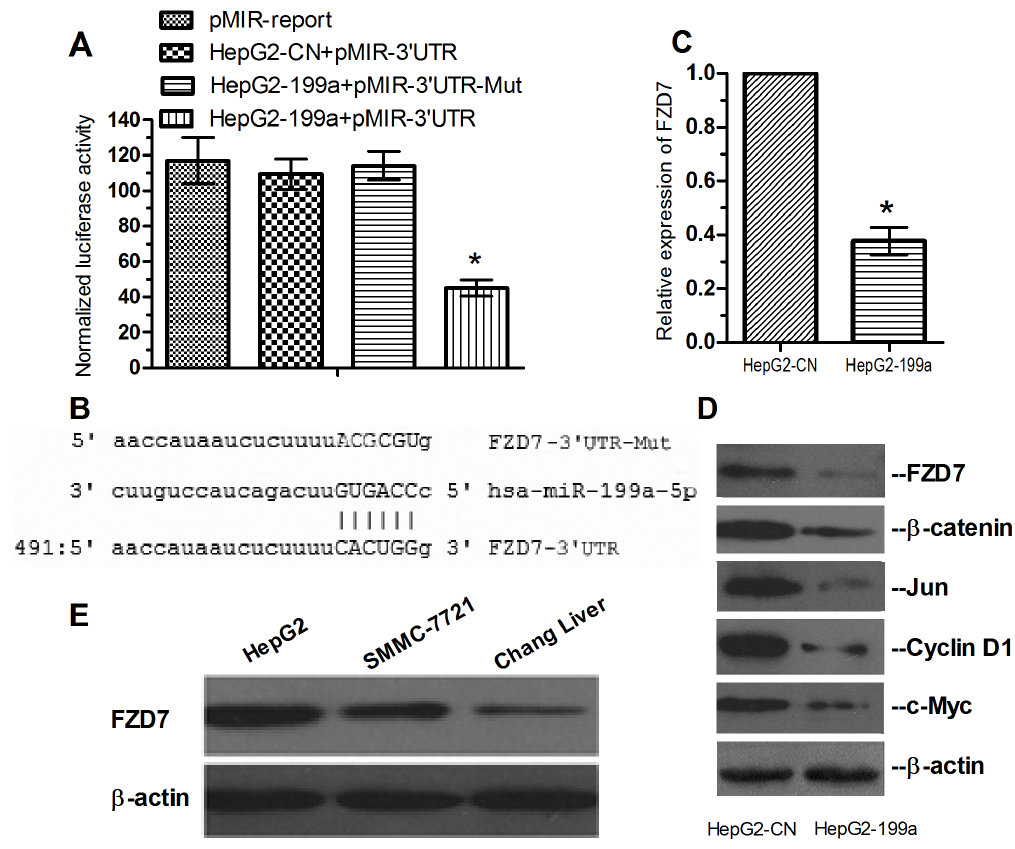
Figure 4. MiR-199a inhibits cell proliferation by directly targeting FZD7. (A) Dual luciferase assays were performed in HepG2-199a and HepG2-NC cells transfected with the firefly luciferase reporter and the control vectors containing Renilla luciferase. The results showed that miR-199a could significantly suppress the luciferase activity of the reporter containing the 3 9 UTR of FZD7 but had no significant effect on the reporter containing the mutated binding site of FZD7. The data shown are the means 6 SD of three independent experiments. (B) The sequences of the miR- 199a binding sites within the 3 9 UTR of FZD7 and the mutated binding site are presented. (C) qRT-PCR analysis showing that the mRNA of FZD7 was significantly decreased in HepG2-199a cells compared with HepG2-NC cells. (D) Western blot analysis confirming that the expression of FZD7 and of its downstream genes was significantly inhibited by miR-199a. b -actin was used as the internal control. (E) The expression of the FZD7 protein in HepG2 and SMMC-7721 cells was higher compared with that in normal Chang liver cells.